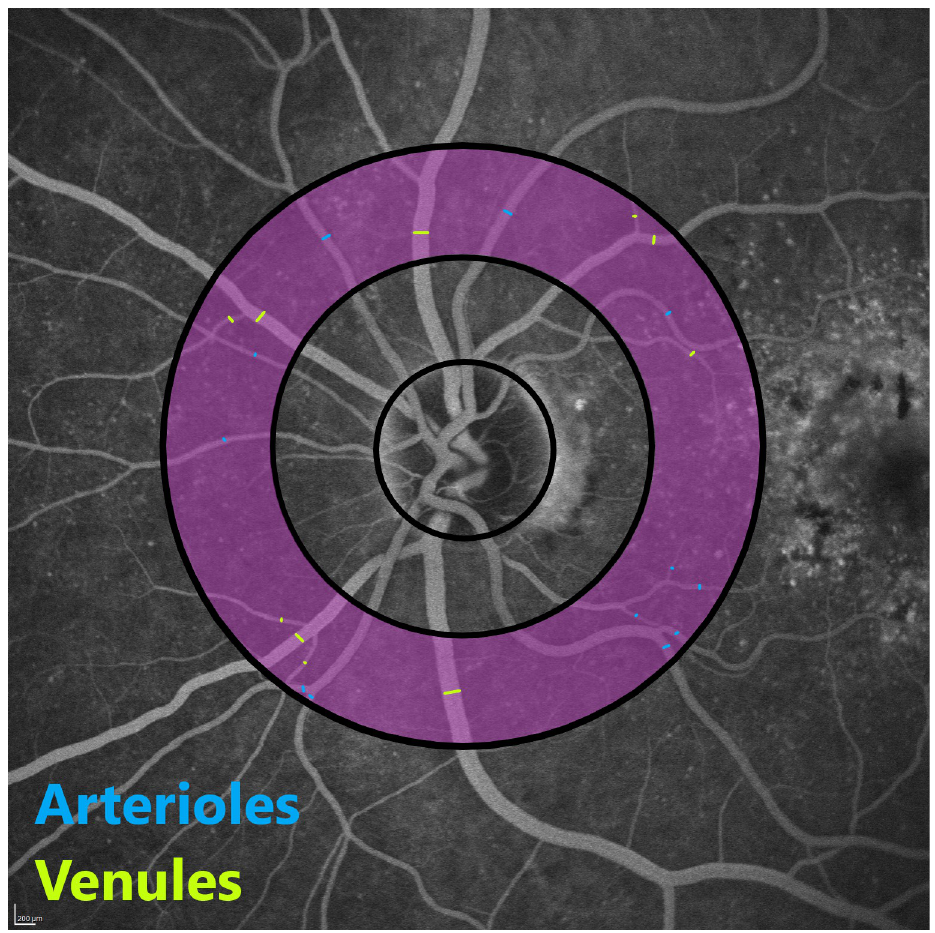
Fig 2. Measurement zone. Optic disc centered fluorescein angiography image (Field 1) at minute five with overlaid grid. The grid is composed of three circles concentric with the optic disc: The innermost circumscribes the average disc, the middle one bounds the annulus from the disc margin to 0.5 disc diameter (DD) from the margin, and the outer one bounds the annulus from 0.5 DD to 1 DD from the disc margin. The measurement zone (magenta) is delimited by the middle and outer circle. Measurements of the arterioles are displayed in blue, venules in